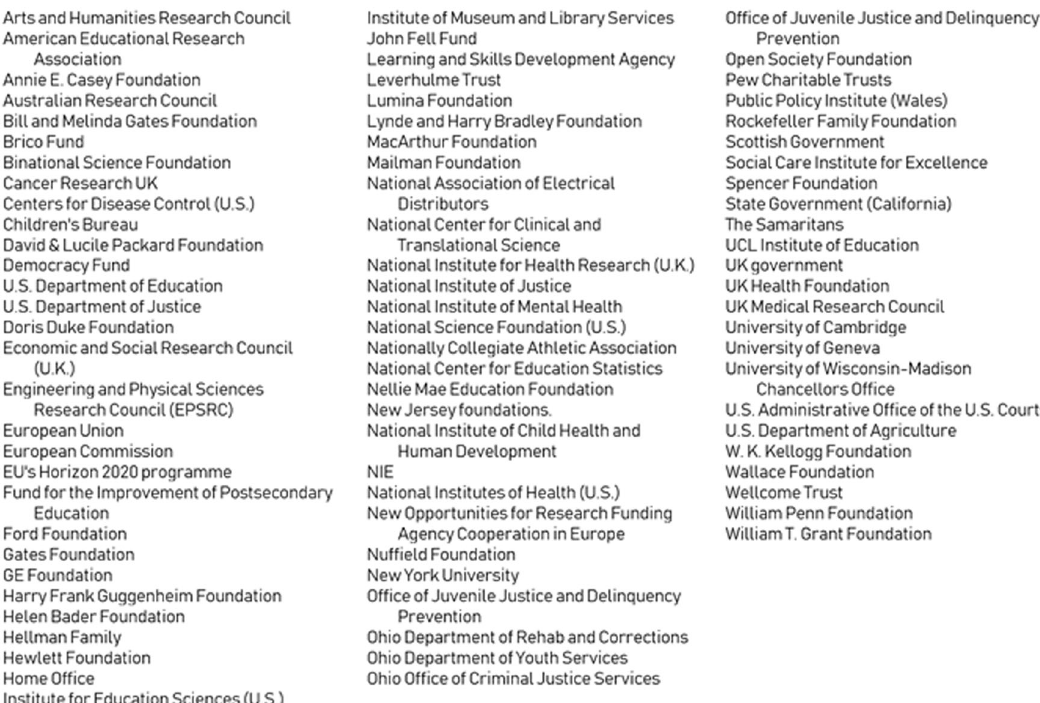
Fig. 2 Self-reported funding sources. Responses to an open-ended item about sources of funding for URE work are listed alphabetically here.